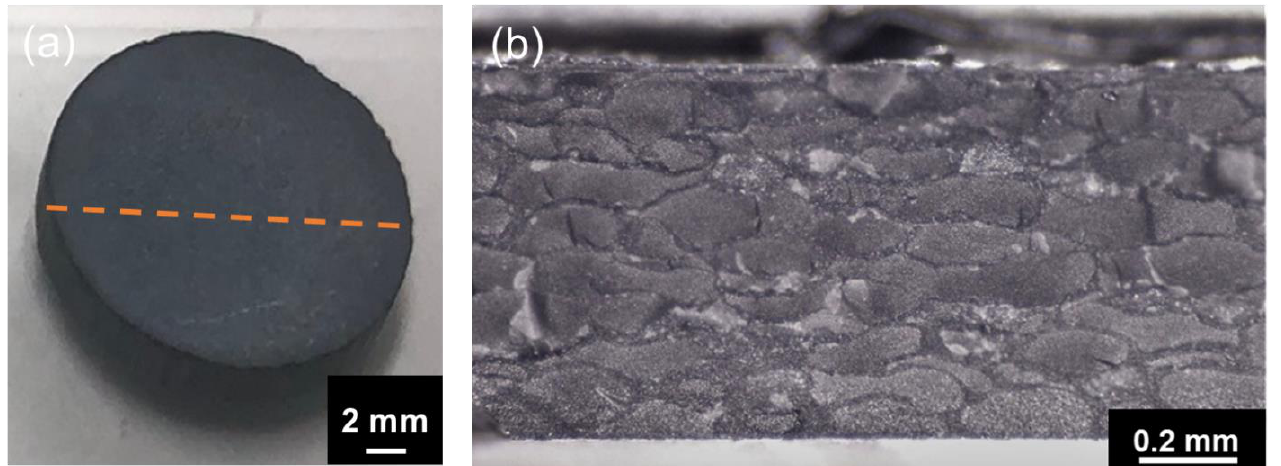
Figure 6. ( a ) The photograph of a sintered artifact obtained using Al 2 O 3 – hBN CS composite granules. ( b ) The cross-sectional optical microscope image taken at the marked line (dotted) in ( a ) showing a unique interconnected mesh-like microstructure.